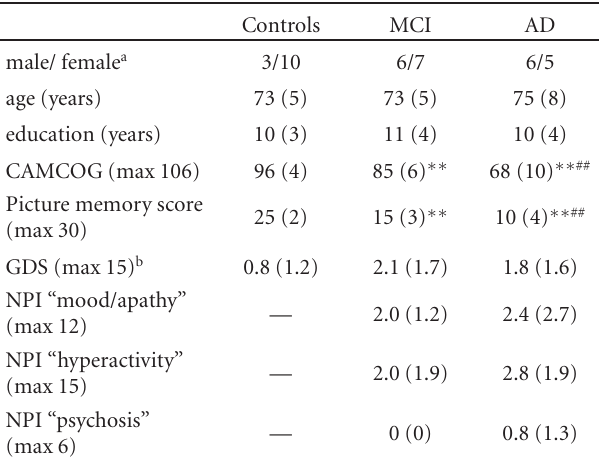
Table 1: Clinical